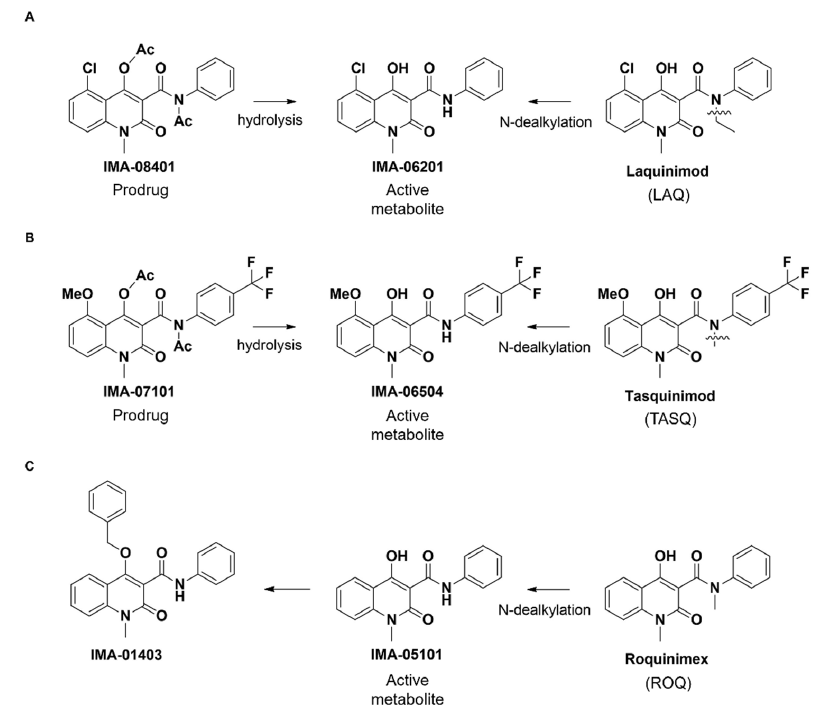
Figure 1. Structure of IMA-compounds. ( A ) Laquinimod (LAQ) is metabolized (N-dealkylation) to form the AHR-active metabolite IMA-06201. Hydrolysis of the prodrug IMA-08401 also forms the IMA-06201 derivative. ( B ) Tasquinimod (TASQ), its AHR-active metabolite IMA-06504, and the prodrug IMA-07101. ( C ) Roquinimex (ROQ), its AHR-active metabolite IMA-05101, and the 4-O-benzyl derivative IMA-01403.